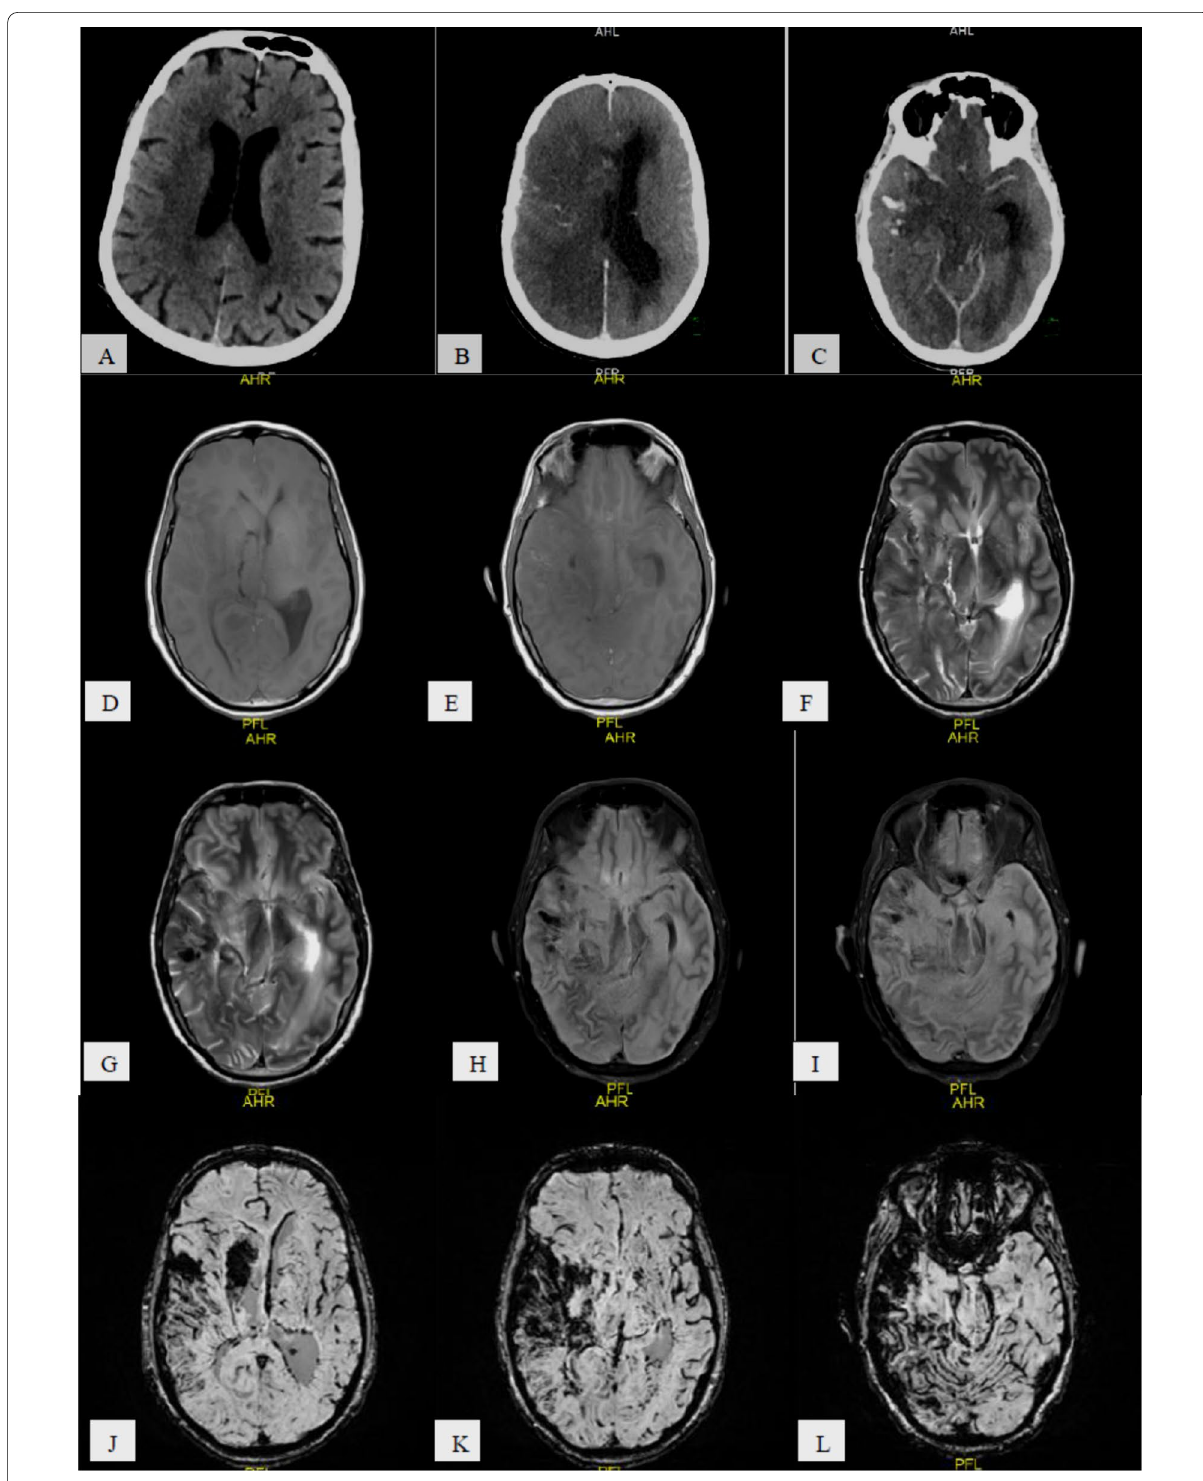
Fig. 2 76-year-old COVID-19 male patient with sudden onset of left sided weakness ( A ) axial CT image shows right temporo-parital ill-defined deep white matter periventricular hypodensity, B , C Follow-up 2 days later of serial axial CT images shows progressive course regarding the size of the right fronto-temporo-parieto-occipital large right cerebral infarction with hemorrhagic component with sub-falcine herniation. D , E T1 WI, F , G T2 WI, H , I FLAIR, J–L SWI, M , N DWI, O , P ADC map , 7 days later MR follow up shows aging right fronto-temporo-parieto-occipital hemorrhagic